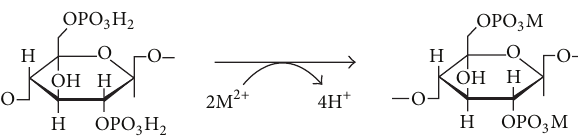
Scheme 1: Ion exchange mechanism of cellulose phosphate.